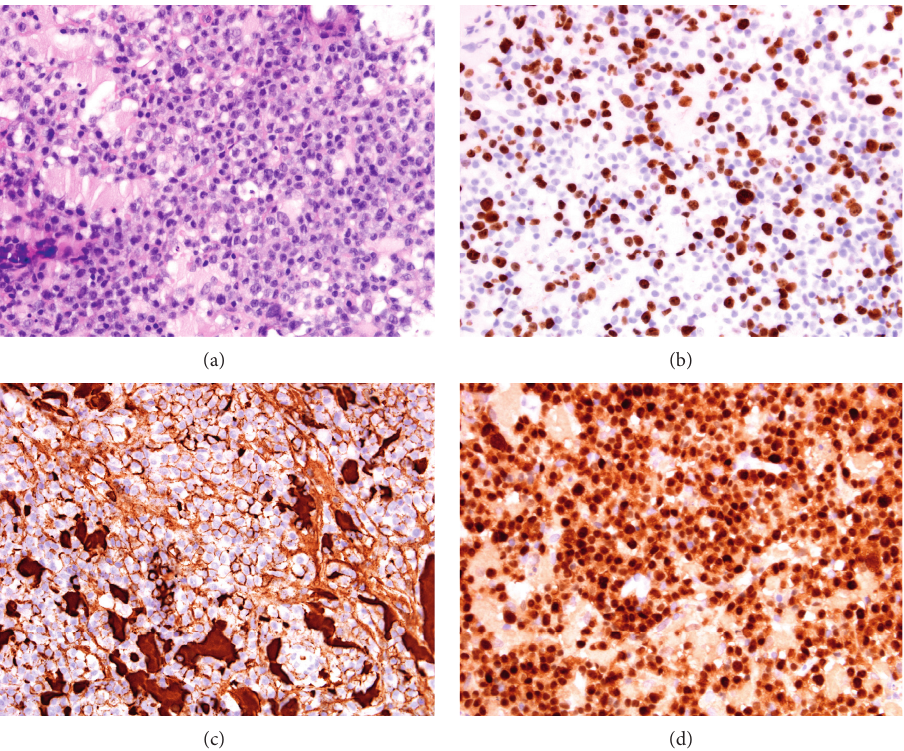
Figure 2: Sheets of large lymphocytes with centroblastic morphology ((a) haematoxylin and eosin stain), with positive immunohisto- chemistry for high Ki-67 index of 70%, CD20, and MUM1 (b)–(d),